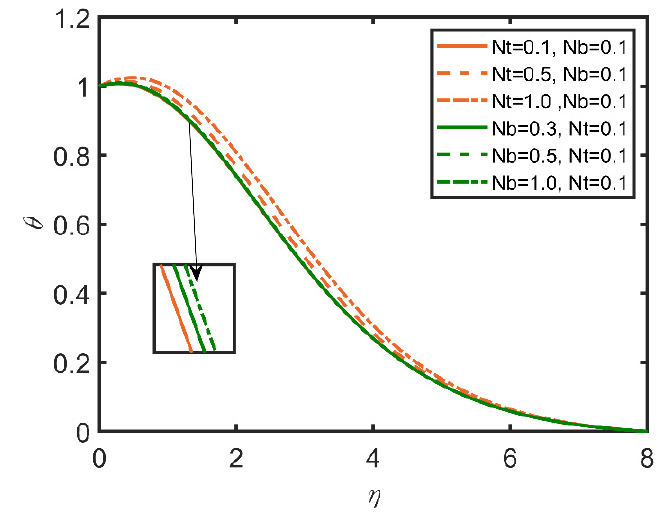
Figure 8. Comparison for temperature profile against 𝜂 .